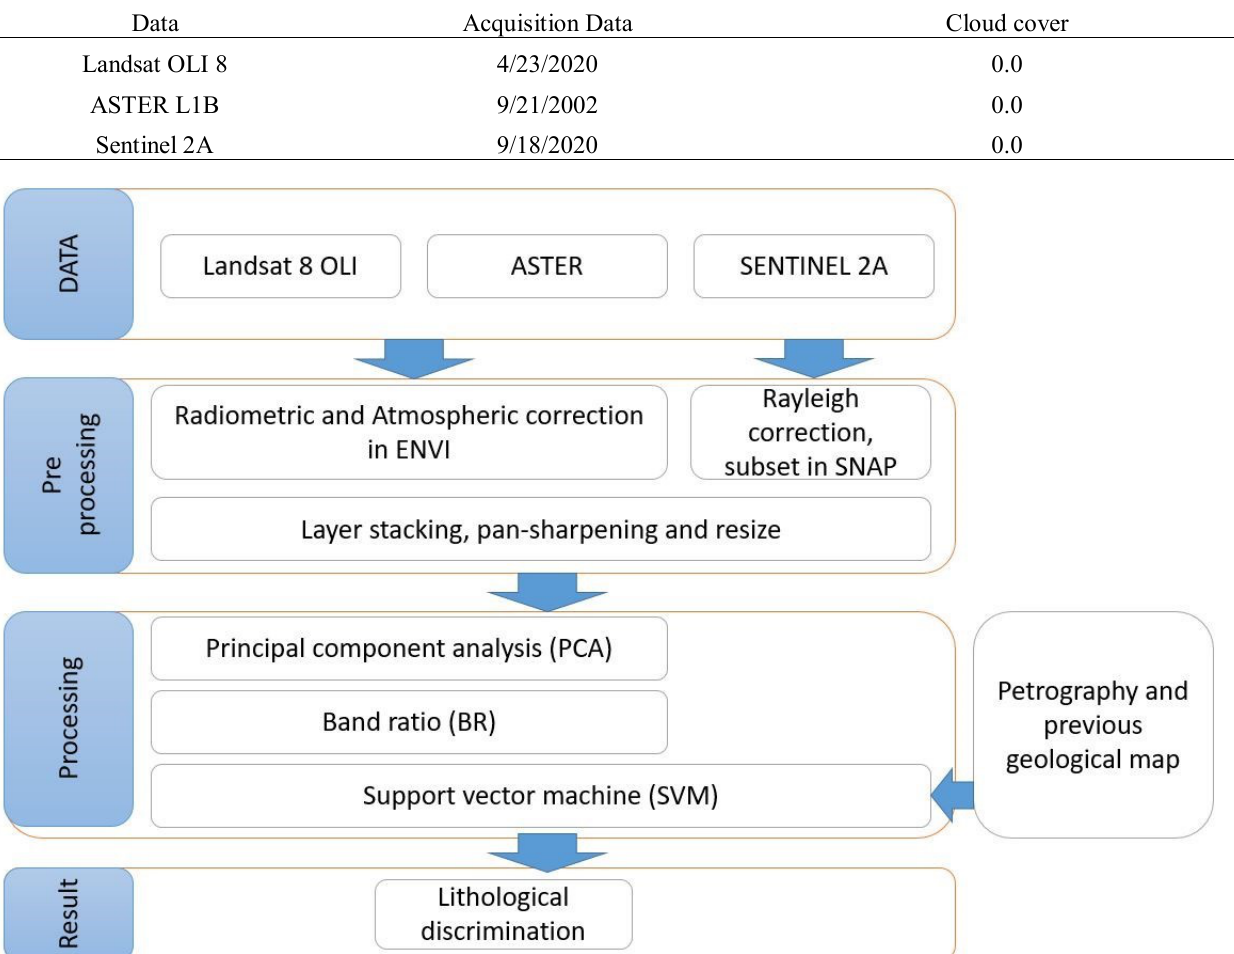
Table 2. Multispectral data used in this study